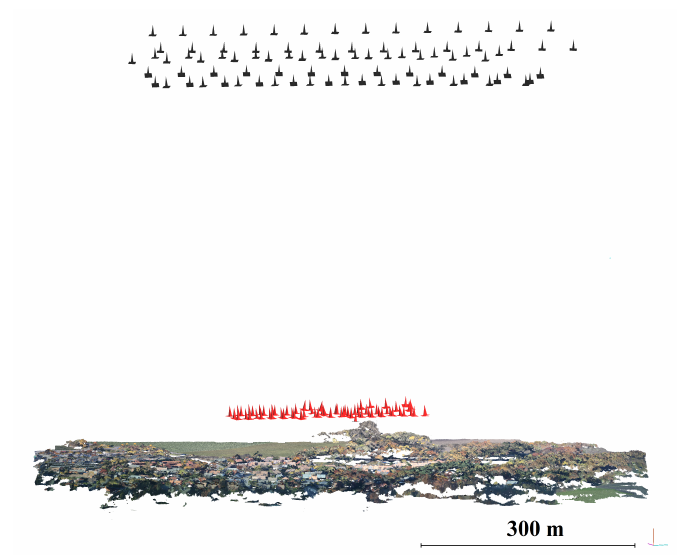
Figure 13. Camera pose visualization for the Eichenau dataset, showing camera poses of the geo-registered UAV image block at a 100-m altitude (red) and the aerial image block at a 600-m altitude (black).